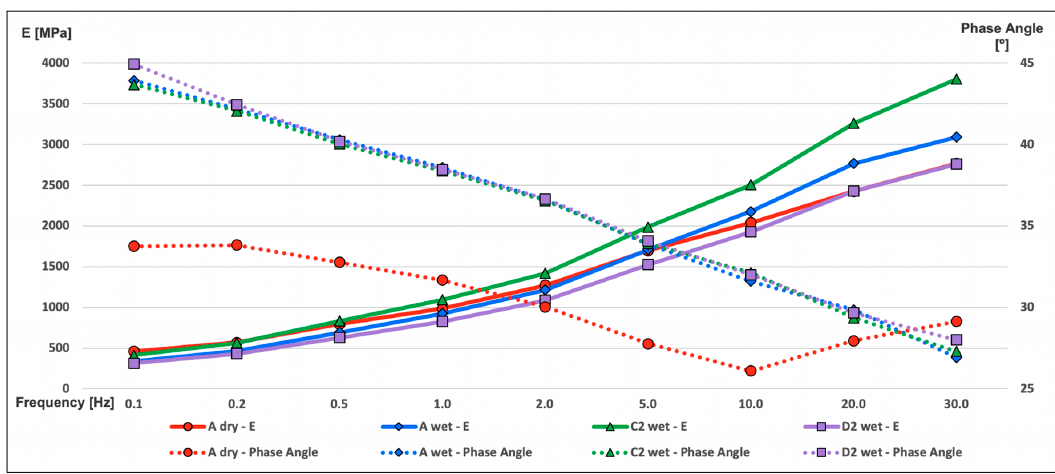
Table 2. Resilient modulus. Standard deviation.